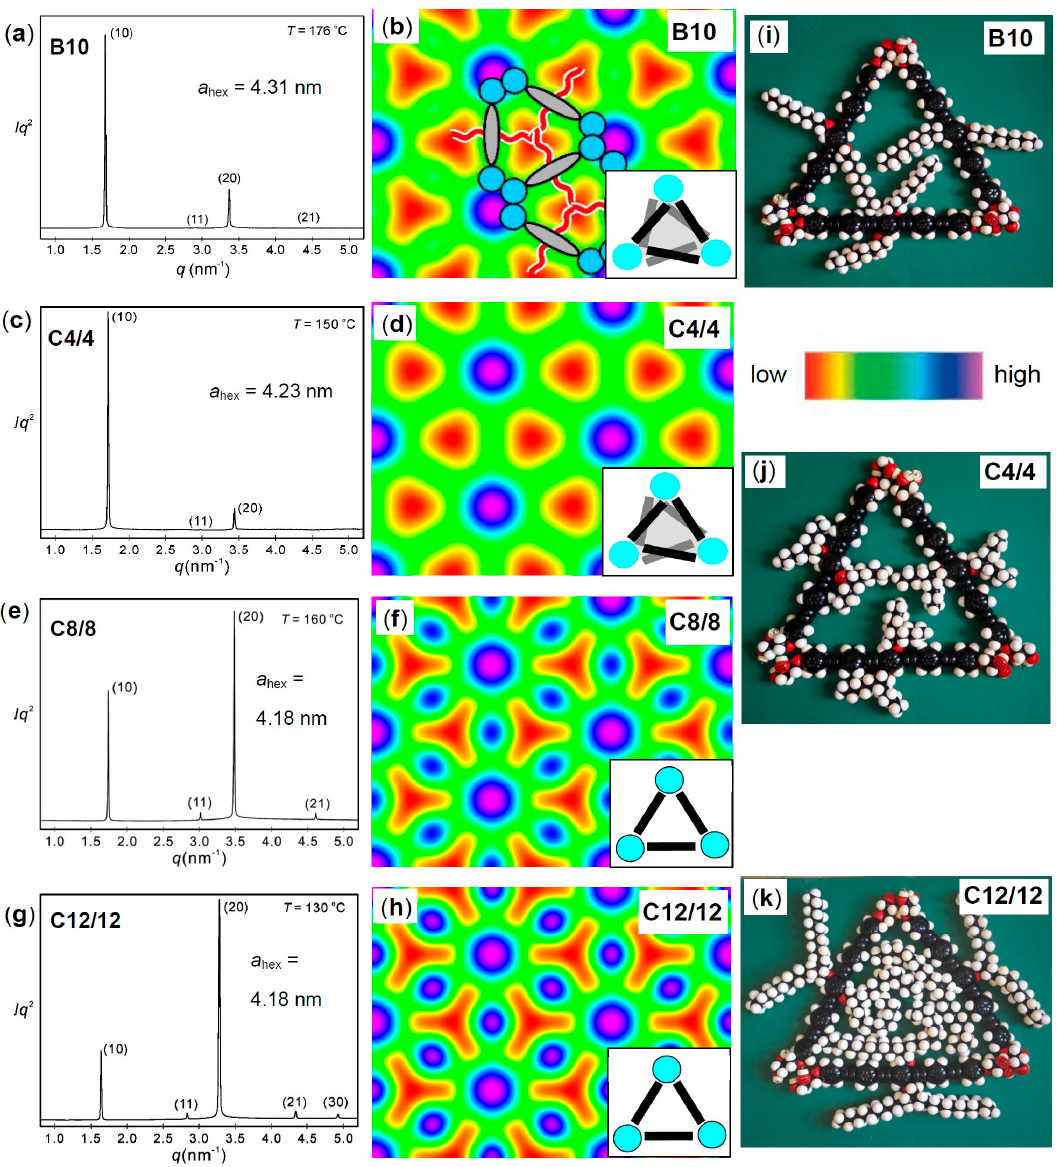
Figure 6. ( a , c , e , g ) SAXS patterns and ( b , d , f , h ) the corresponding reconstructed ED maps of the hexagonal columnar phases (used phase combination is 0 π 0 π ) of the noted compounds at the given temperatures; ( i , j , k ) show the organization of three molecules B10 , C4/4 , and C12/12 , respectively, in the cross-section of a triangular cell with only one molecule in the lateral cross-section of the honeycomb walls ( n wall = 1.0); in ( k ), the space in the triangular cells is completely filled, whereas there is significant excess free space in the cells in ( i , j ). The insets show the models of the phase structures (see also Figure 7); for numerical XRD data, see Table S1, for representative WAXS patterns, see Figure S6a–c.